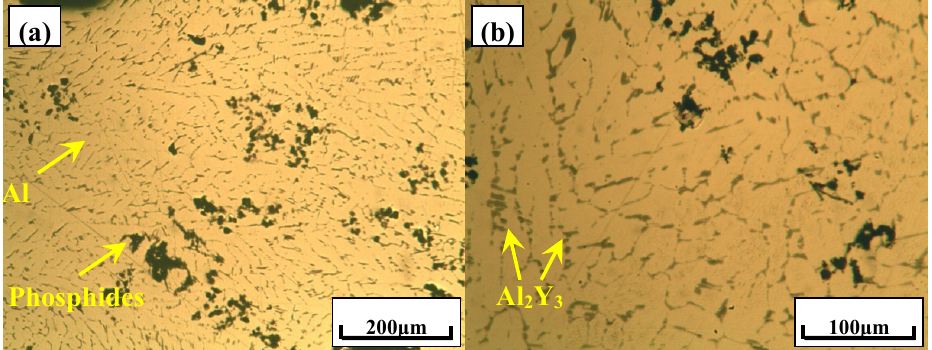
Figure 4. Typical microstructures of Al–2Ca–3Y–1P alloy. ( a , b ) Both of these two pictures are the typical microstructures of this alloy.